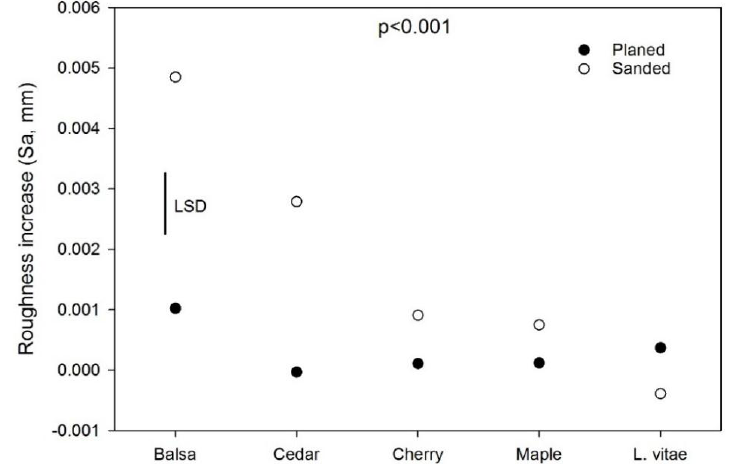
Figure 2. Grain raising of sanded and planed wood surfaces. Differences in roughness that exceed the length of the error bar (LSD) are statistically significant ( p < 0.05).